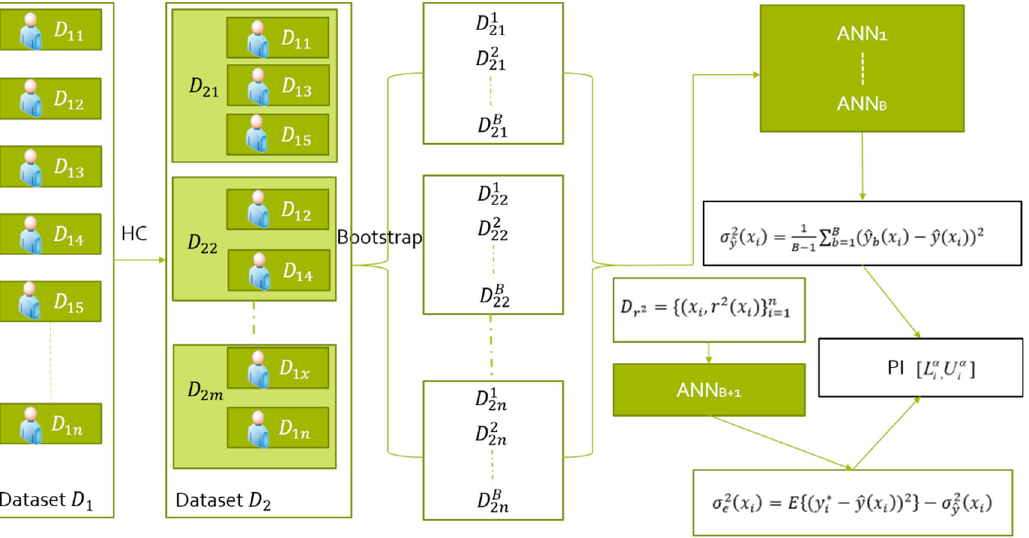
Figure 3. Model framework of bus travel time PIs based on driver driving style clustering and bootstrap.